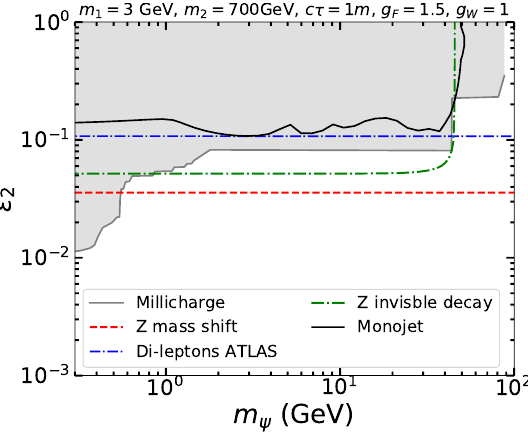
Figure 1 . The 95% CL exclusion limits on (cid:15) 2 as a function of m . We use the following parameters: m 1 = 3 GeV, m 2 = 700 GeV, g F = 1 : 5, g W = 1 : 0, and c(cid:28) = 1 m. Shown are the millicharged particle searches at the colliders (shaded light gray) [33], electroweak constraints due to the Z mass shift (dashed red), the Z invisible decay (dash-dotted green) [29], the di-lepton high mass resonance search at ATLAS (dash-dotted blue) [32], and the mono jet search at ATLAS (solid black) [34].